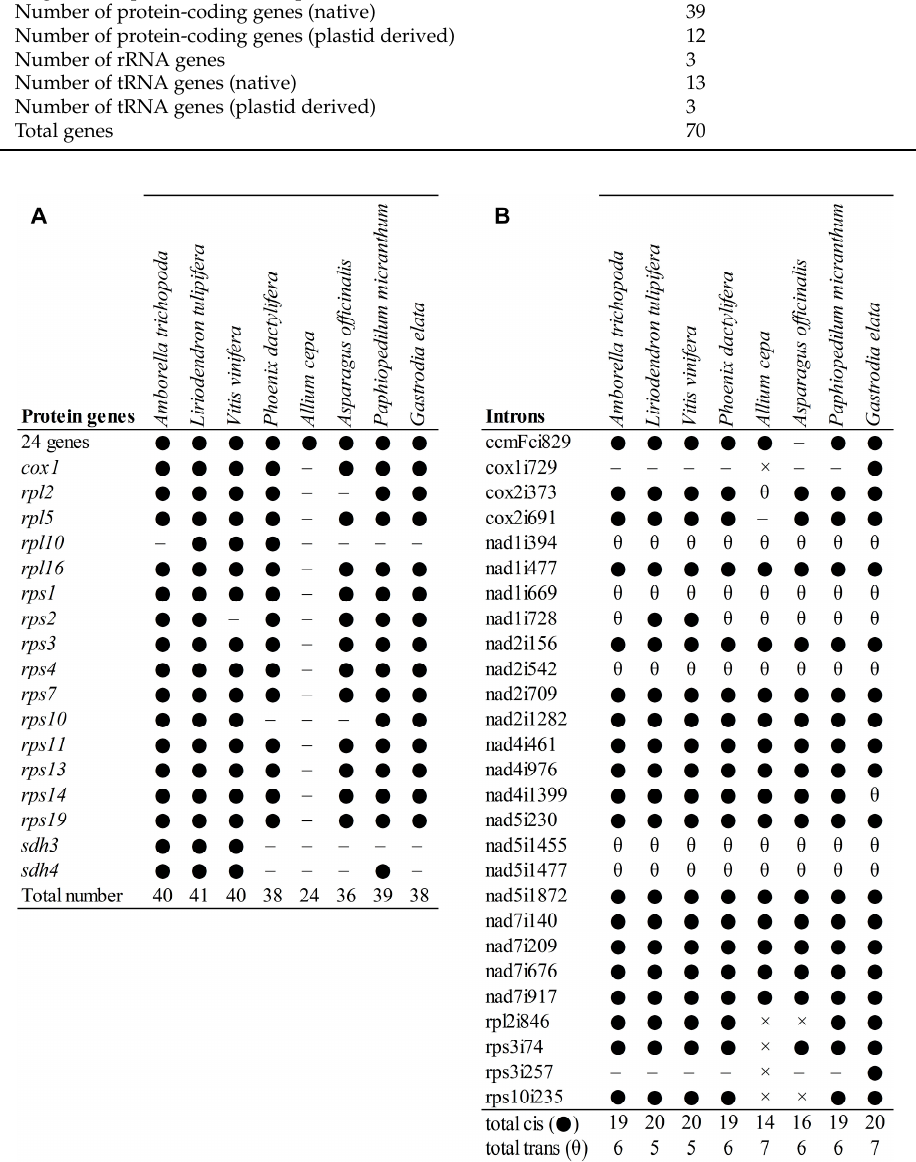
Figure 2. Comparison of the protein-coding gene content and group II intron content of Paphiopedilum micranthum and selected angiosperms. ( A ) protein-coding gene content. ● indicates present, – indicates lost; the 24 genes present in all sampled species include atp1 , atp4 , atp6 , atp8 , atp9 , ccmB , ccmC , ccmFc , ccmFn , cob , cox2 , cox3 , matR , mttB , nad1 , nad2 , nad3 , nad4 , nad4L , nad5 , nad6 , nad7 , nad9 , and rps12 . ( B ) group II intron content. ● indicates cis-spliced intron present, – intron lost, θ trans-